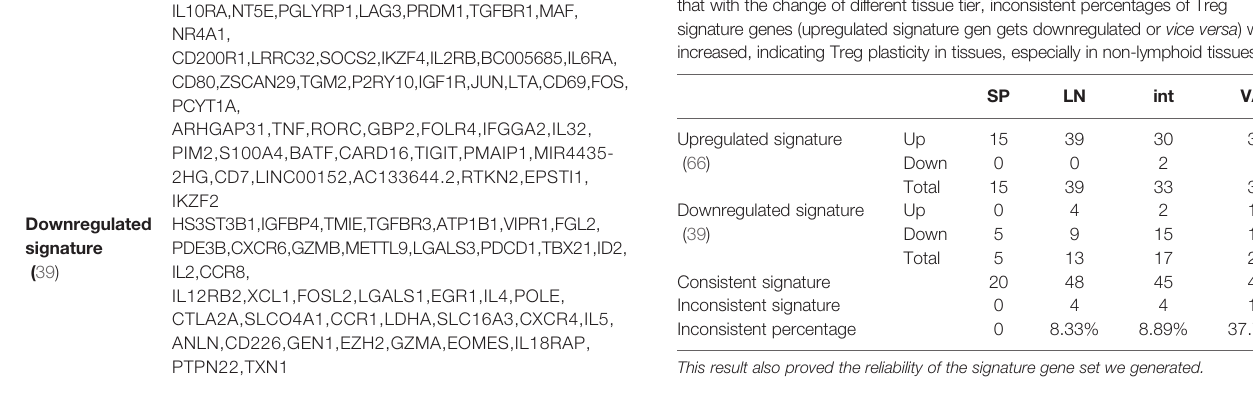
TABLE 5 | Comparison of signature genes in four tissues in our study showed that with the change of different tissue tier, inconsistent percentages of Treg